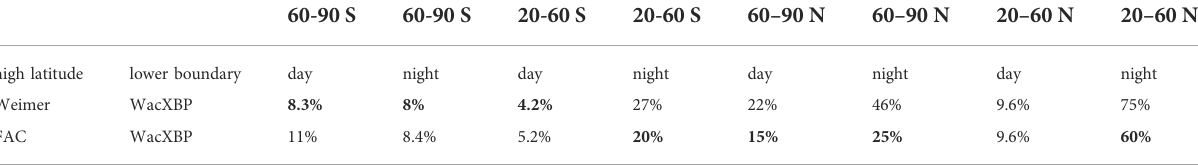
TABLE 3 Relative error with respect to the absolute observed neutral density | ρ model − ρ data | 1 /| ρ data | 1 averaged over doy 30 – 34 for different high latitude